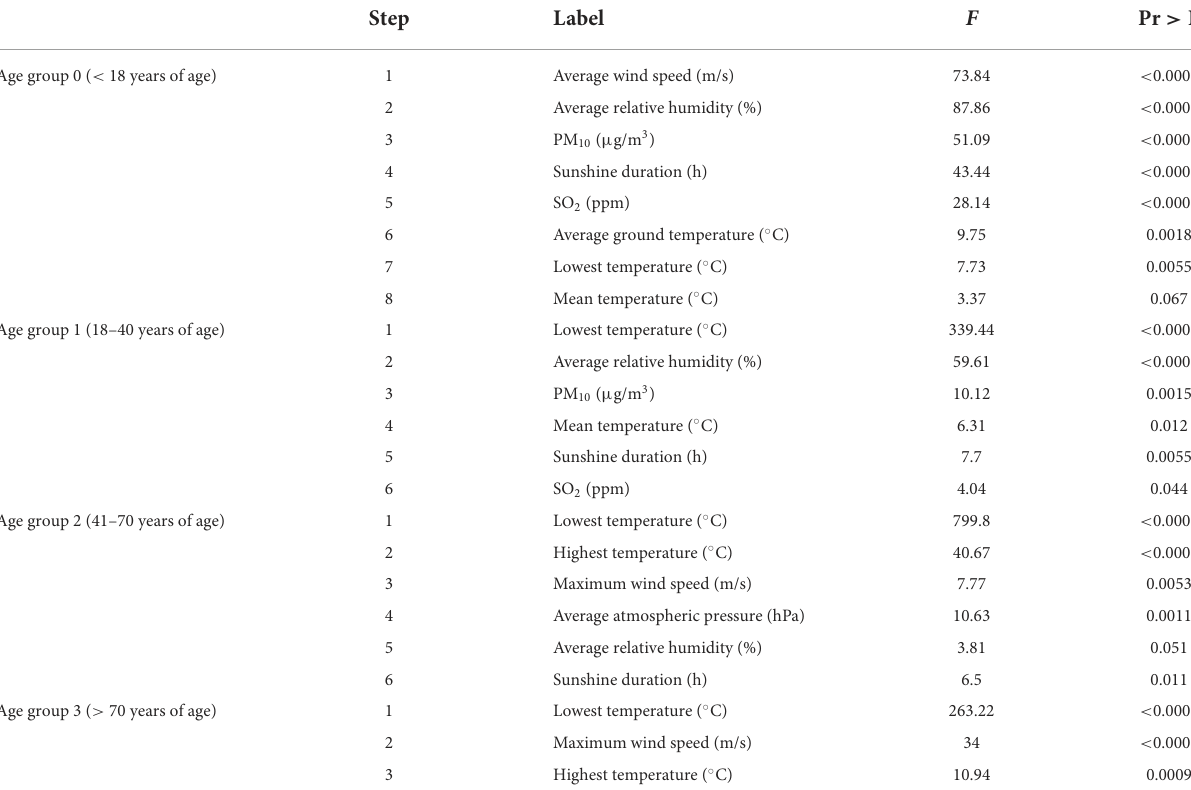
TABLE 2 Stepwise regression model for the environmental risk factors of epistaxis in each age group. Step